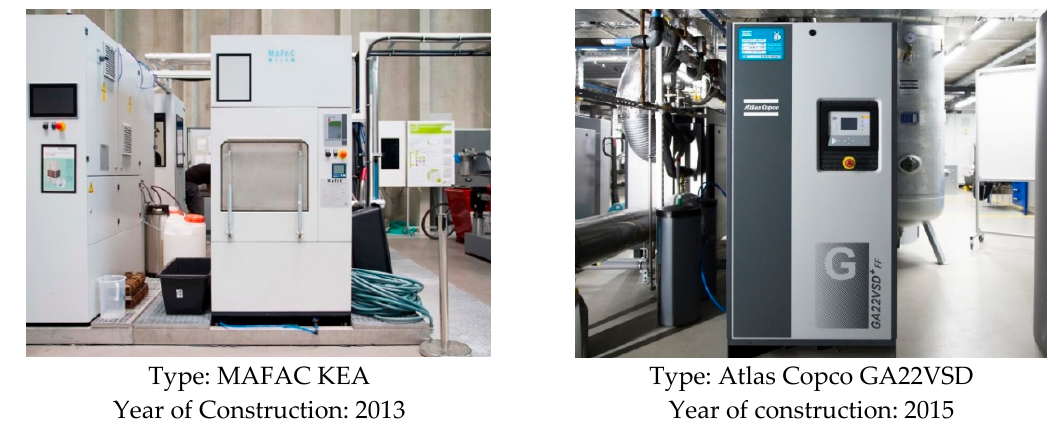
Figure 12. Cleaning machine (left) and compressed air genereator (right) in the ETA-Factory.